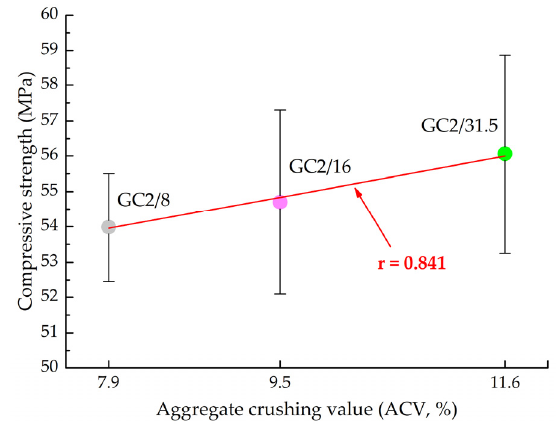
Figure 4. Correlation between aggregate crushing value and compressive strength of concrete.